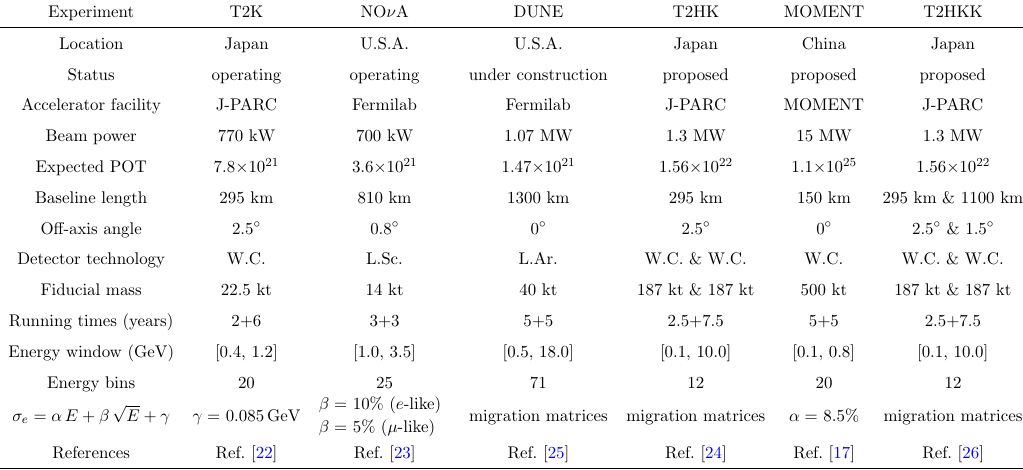
Table 1. The experimental inputs assumed in the simulation of MOMENT and the long baseline experiments T2K, NO (cid:23) A, DUNE, T2HK and T2HKK. The energy resolution is given in terms of (cid:27) e , which corresponds to the width of the Gaussian distribution. nology in ref. [31], and atmospheric neutrino background suppression in refs. [32] and